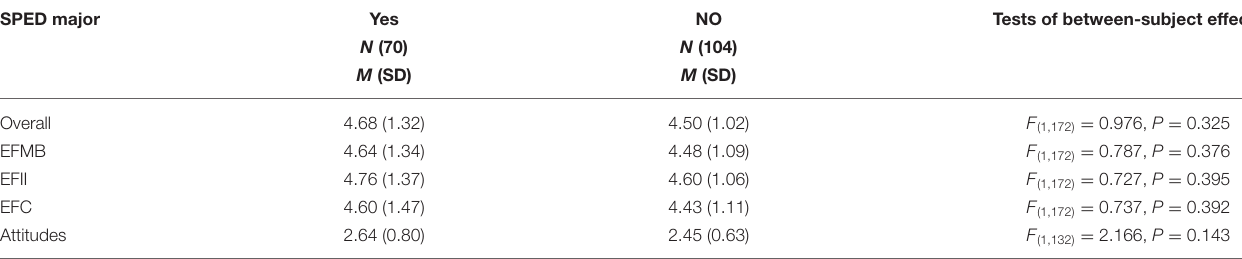
TABLE 3 | Means/standard deviations and ANOVA statistics by teachers’ major.